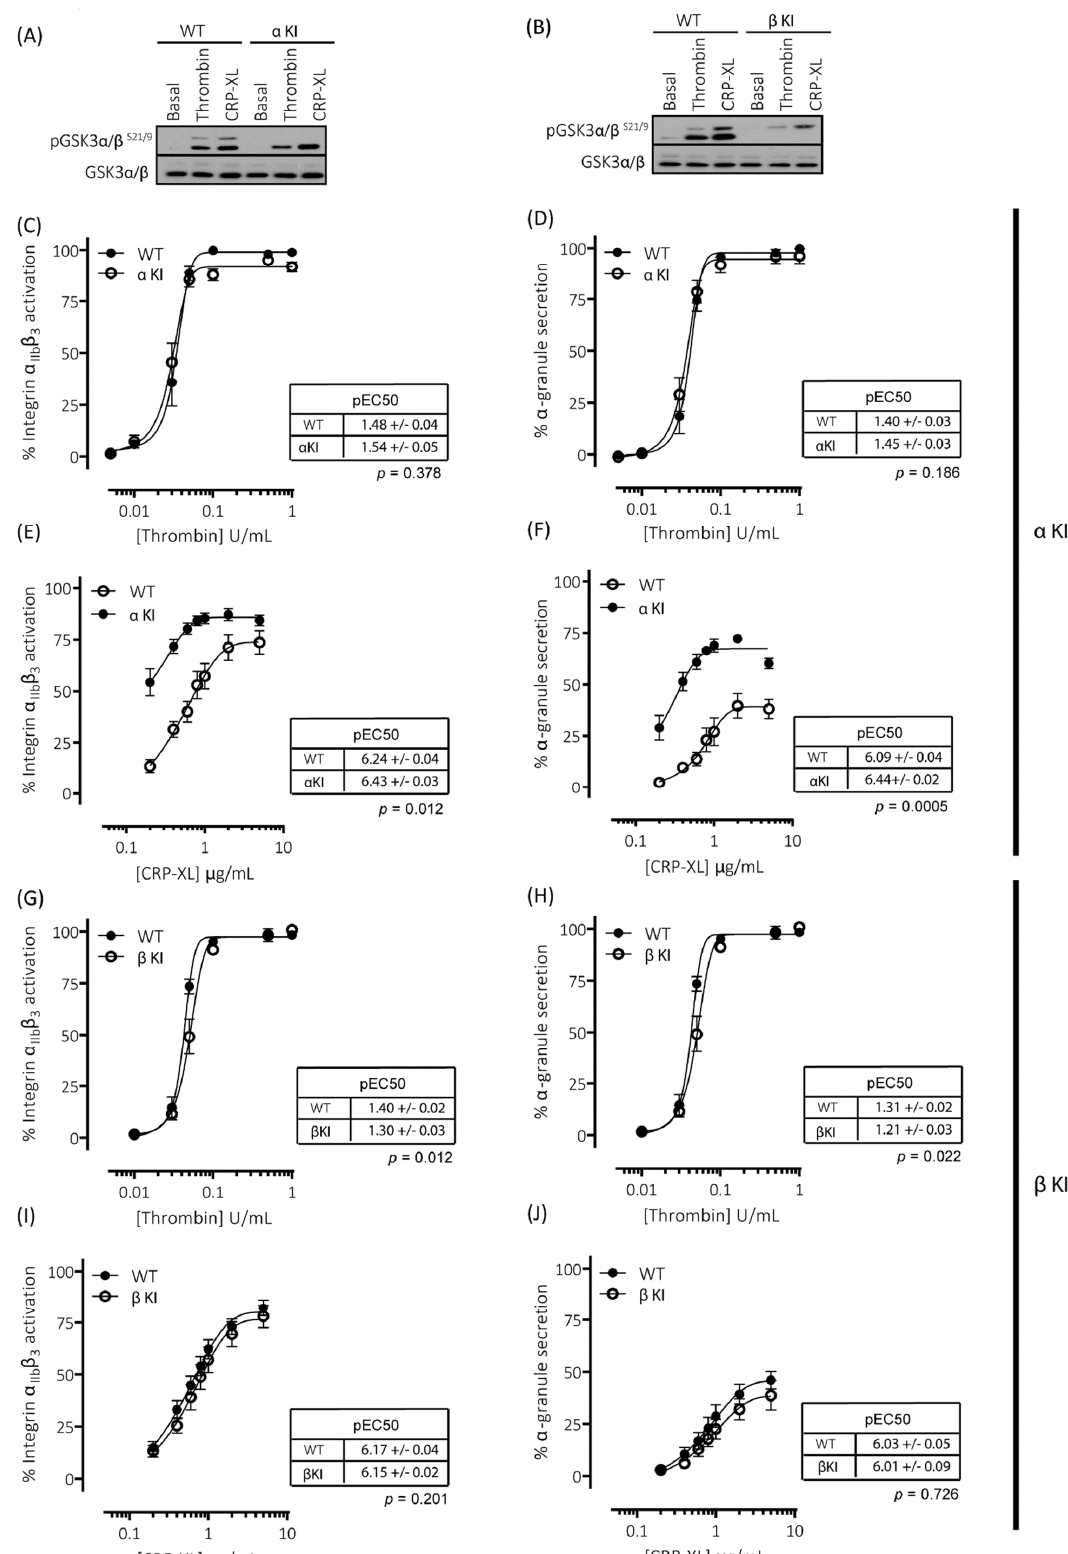
Figure 3. Platelets expressing phosphorylation-resistant GSK3 α or GSK3 β have altered responses to thrombin and CRP-XL: ( A ) Immunoblotting of platelets from mice expressing phosphorylation-resistant GSK3 α ( α KI) confirmed the absence